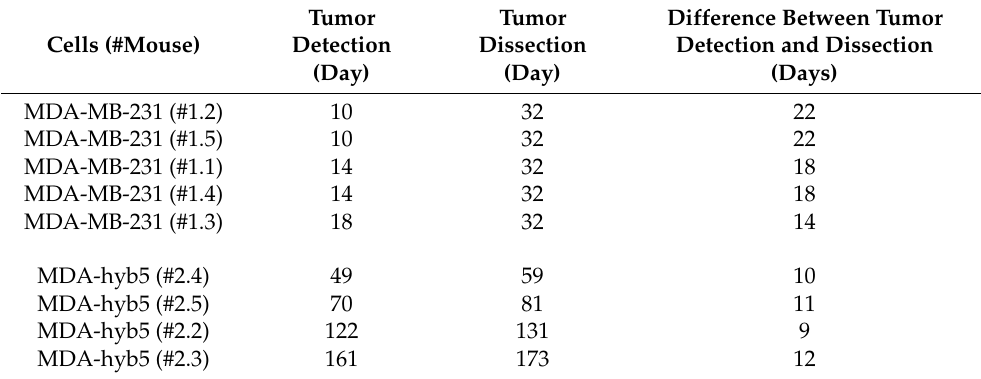
Table 1. Analysis of tumor development in MDA-MB-231 and MDA-hyb5